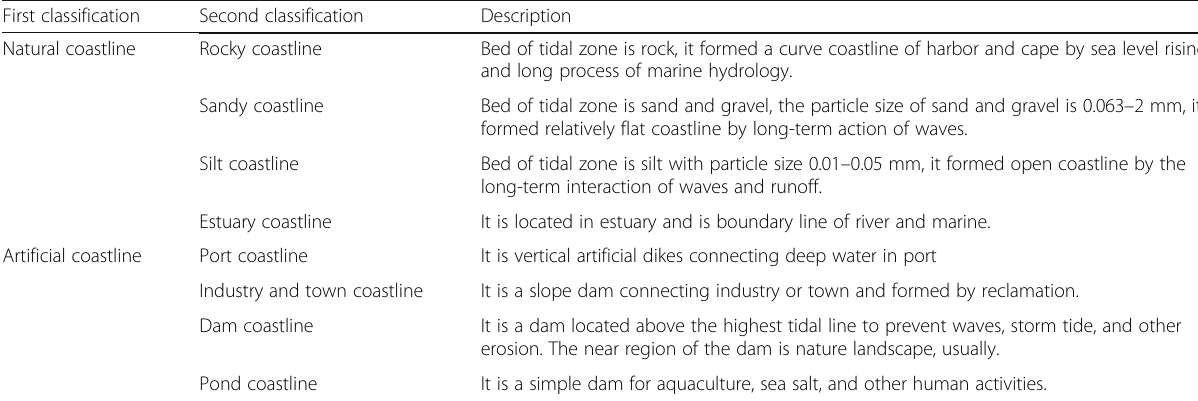
Table 2 The coastline classification system and their description